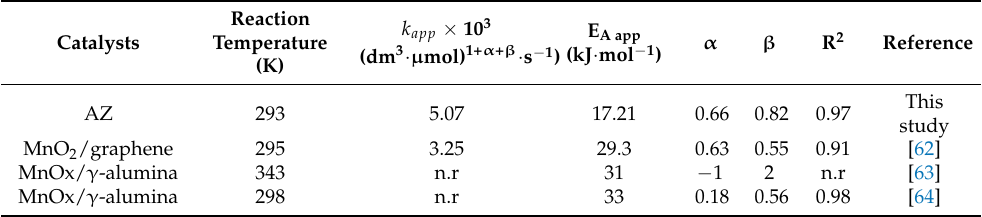
Table 1. Power law kinetic parameters for catalytic ozonation of